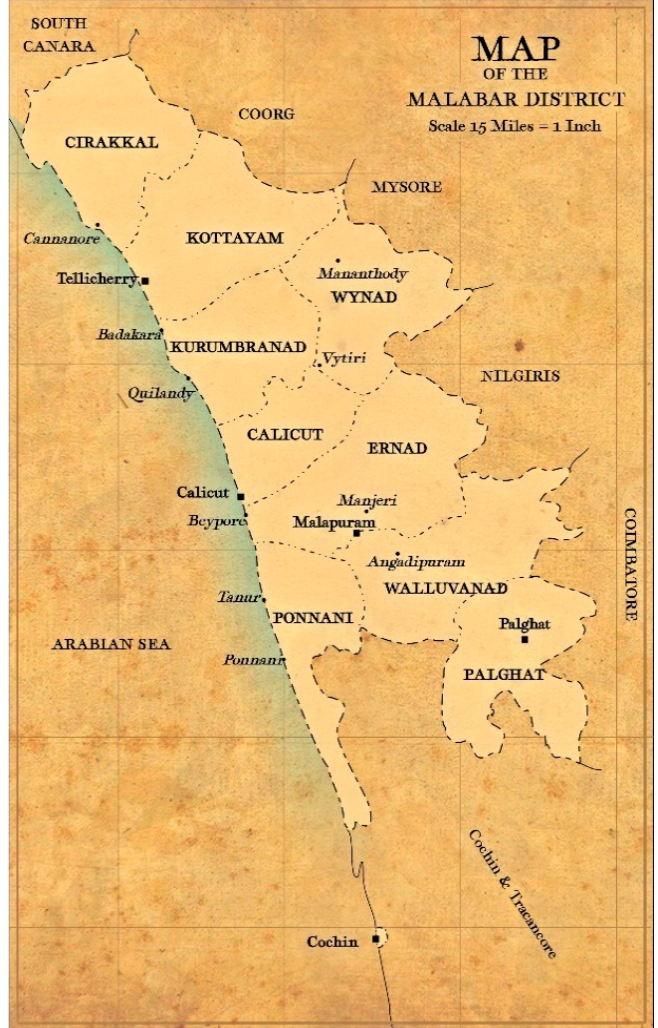
Figure 2. Source: Created by referring to the Gazetteer and other records. Geographical extent of the Malabar District, Kerala with its revenue divisional head-quarters and Taluks. Cirakkal, Kottayam, Wayanad, Kurumbranad, Calicut, Ernad, Ponnani, Walluvanad, and Palghat together form the Malabar. (https://upload.wikimedia.org/wikipedia/commons/f/fb/Malabar_District_Map.jpg, accessed on 20 January 2021). The Nilgiris or the Blue Hills is the north eastern Hill district of Tamil Nadu and is bounded by the States of Karnataka in the North; Kerala in the West and two districts of